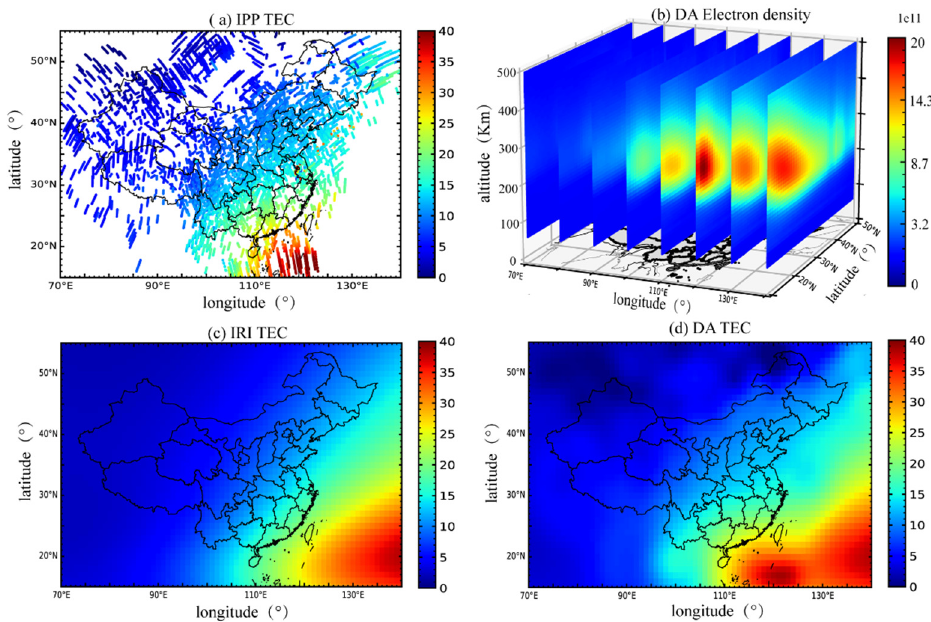
Figure 6. Electron density assimilation results at 00:00 UT on 1 January 2015. ( a ) VTEC of pierce point; ( b ) electron density distribution after assimilation (upper right); ( c ) VTEC calculated by IRI model (lower left); ( d ) VTEC after assimilation (lower right).